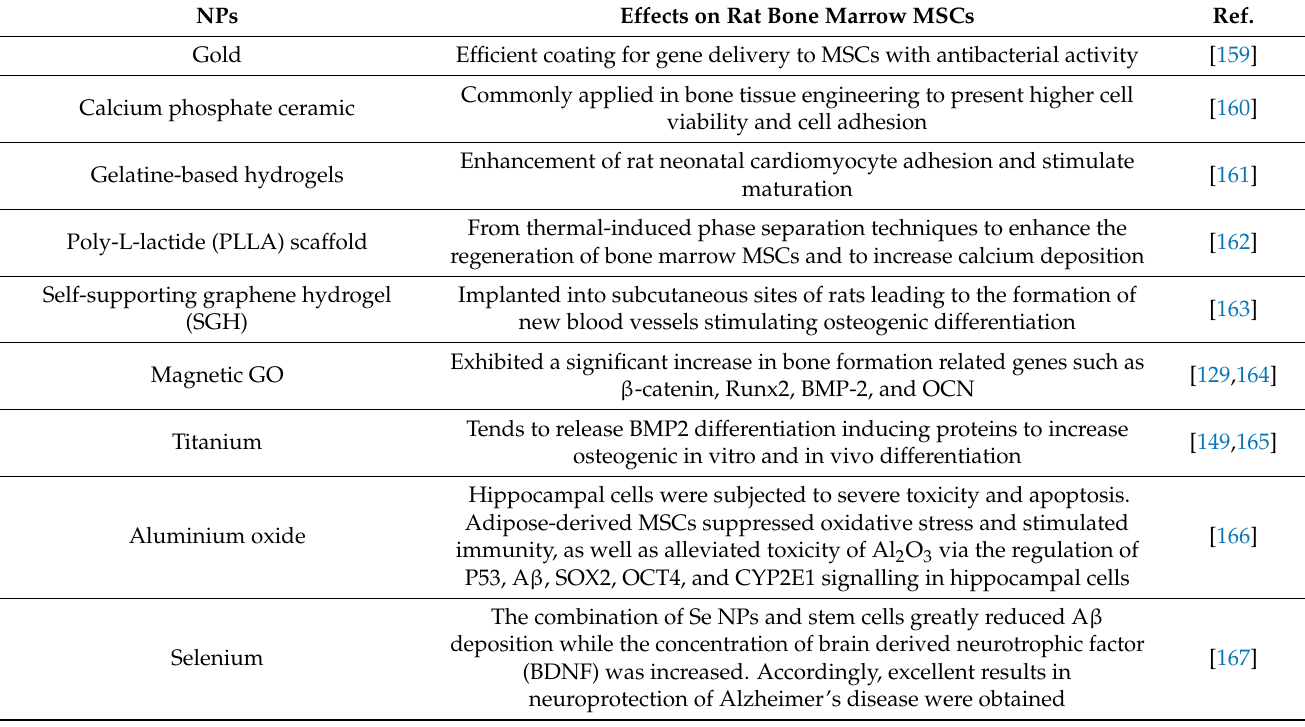
Table 2. Effects of various NPs on Rat Bone Marrow